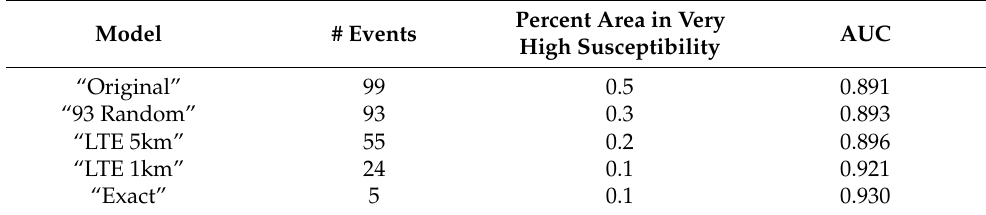
Percent Area in Very AUC High Susceptibility